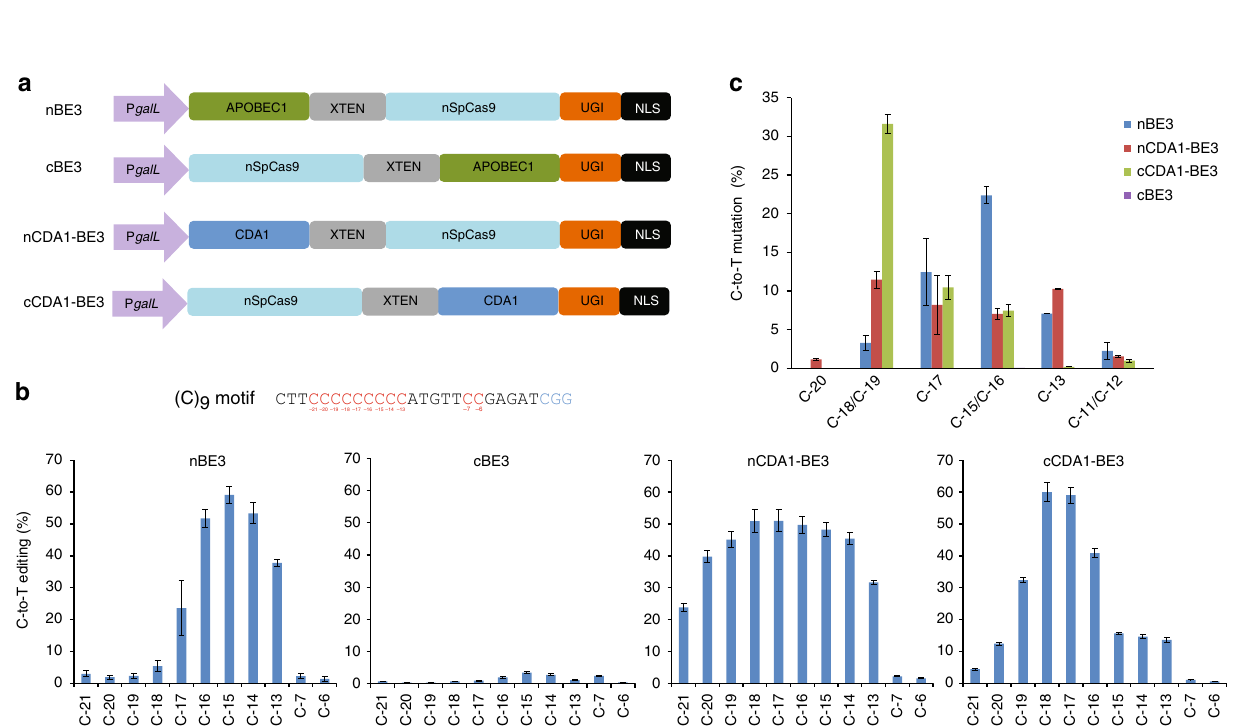
Fig. 2 Comparison of N- and C-terminal deaminase fusions to nCas9. a Structure of nBE3 ( = BE3; ref. 16 ), cBE3, nCDA1-BE3, and cCDA1-BE3 driven by the GalL inducible promoter. In all constructs, the XTEN linker separates the nucleoside deaminase domain from the nCas9 domain. nSpCas9: Streptococcus pyogenes Cas9 nickase. b Base editors with the deaminase at the N-terminus show broadened base editing windows. The sequence of the target (C) 9 motif is shown with the numbers representing the position of possible editing targets (red) relative to the PAM (blue). % of C-to-T editing represents the percentage of total sequencing reads with the target C converted to T. c Base editing outcome of nBE3, cBE3, nCDA1-BE3, and cCDA1-BE3 targeting several sites containing target Cs at different positions (indicated on the x -axis) in the Can1 gene (cf. Supplementary Figure 1; Supplementary Table 4). Values and error bars represent the mean and standard deviation of three independent biological replicates. Source data underlying panels b and c are provided as a